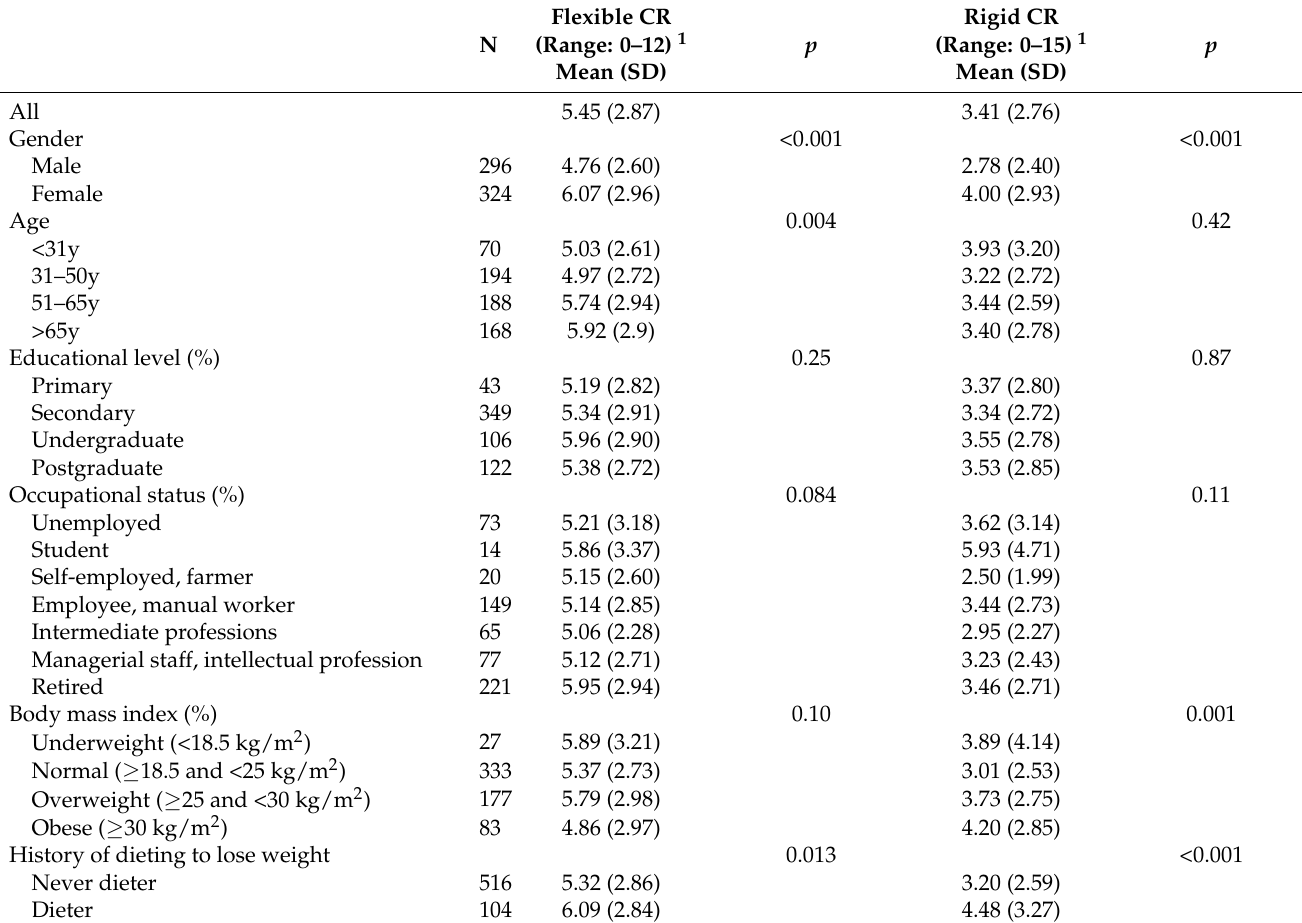
Table 3. Differences between flexible and rigid cognitive restraint (CR) dimensions according to socio-demographic and anthropometric characteristics among 620 participants of the NutriNet-Sant é study (2017). Flexible N